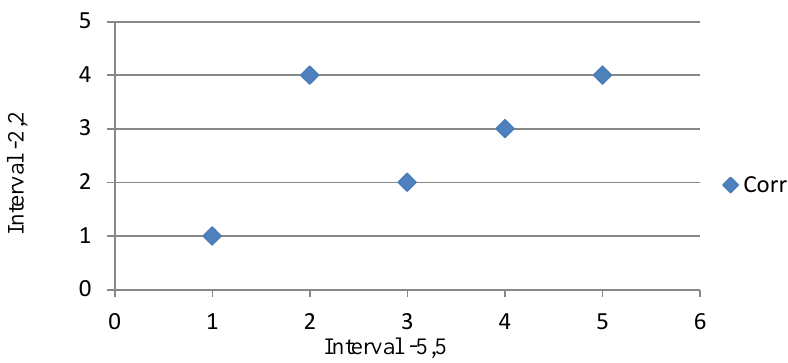
Figure 4. Spearman’s correlation of results from interval [-5.5] and